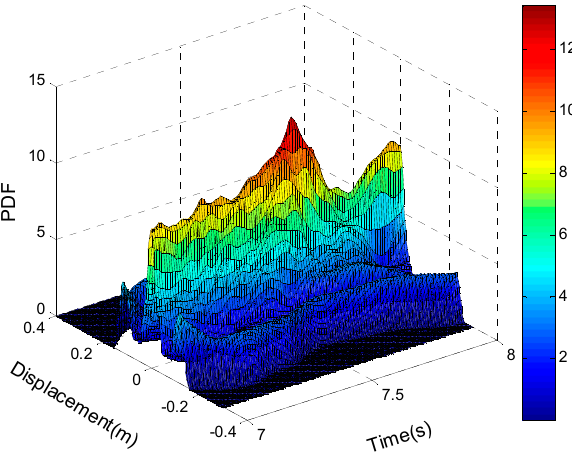
Figure 9. PDFs evolution surface of displacement.